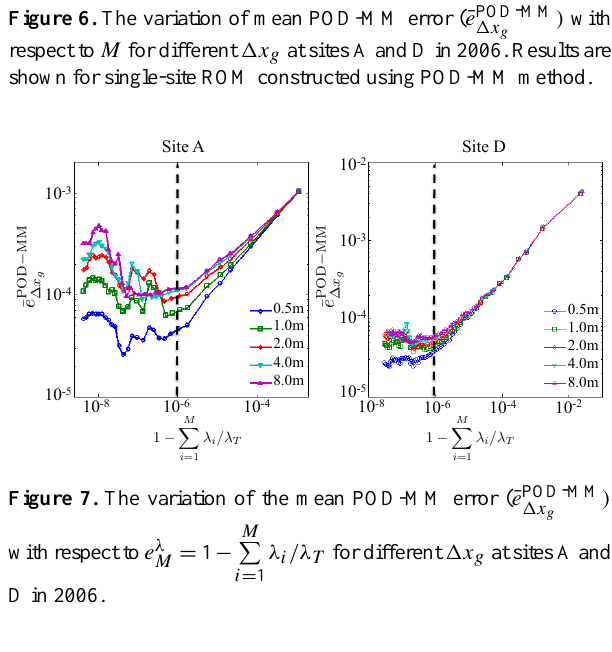
Figure 7. The variation of the mean POD-MM error ( ¯ e POD - MM M P = 1 − λ i /λ T for different 1x g at sites A and with respect to e λ M i = 1 D in